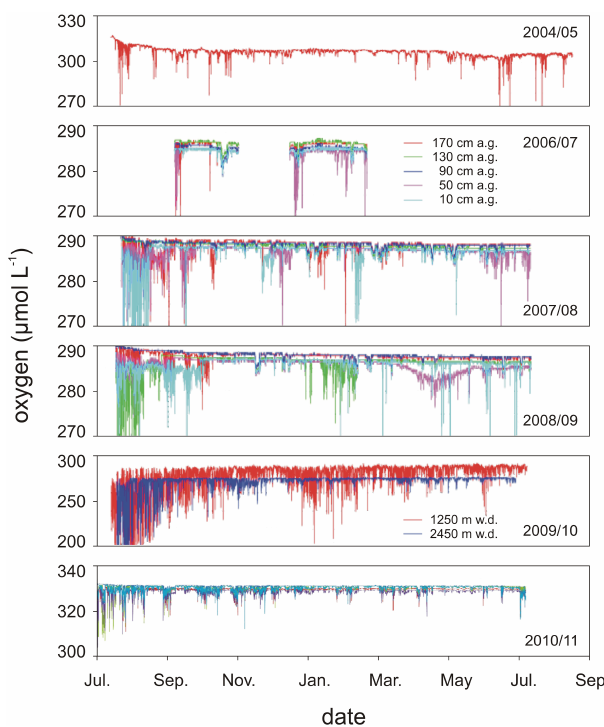
Fig. 26. Oxygen time-series records obtained using optical oxy- gen sensors (“optodes”; types 3830 and 4330, AADI, Bergen, Nor- way) from single-sensor and multisensor instruments deployed at the HAUSGARTEN observatory between July 2004 and July 2011 (a.g.: height of sensors above ground; w.d.: station water